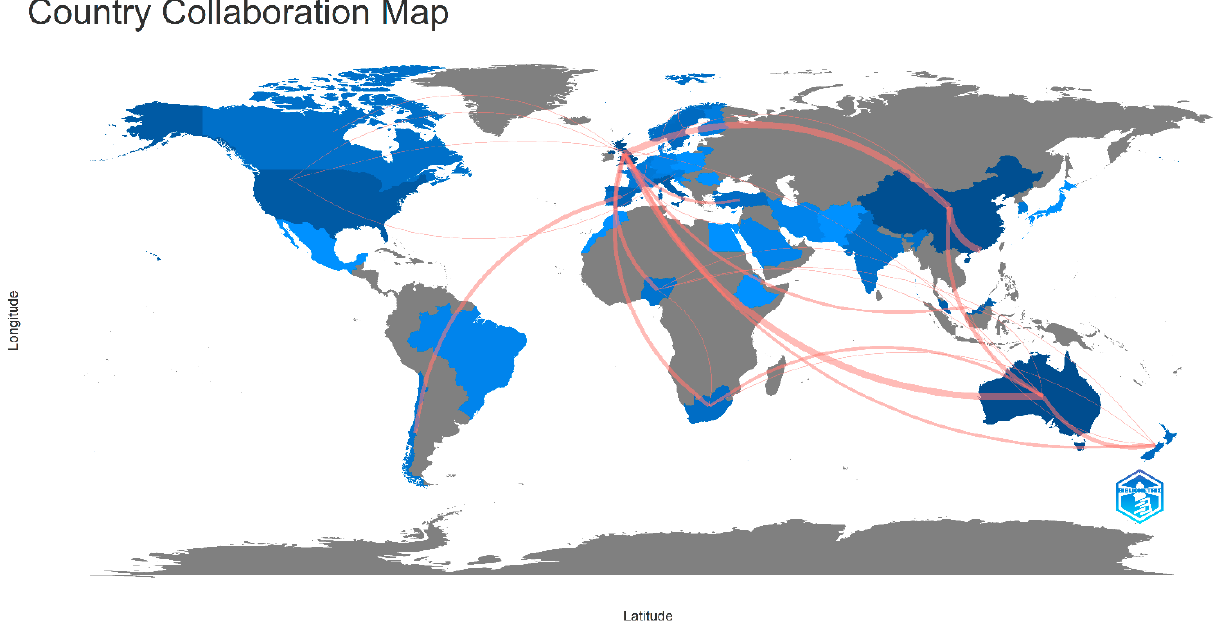
Figure 10. Countries’ collaboration map analysis performed with Biblioshiny version 4.0.